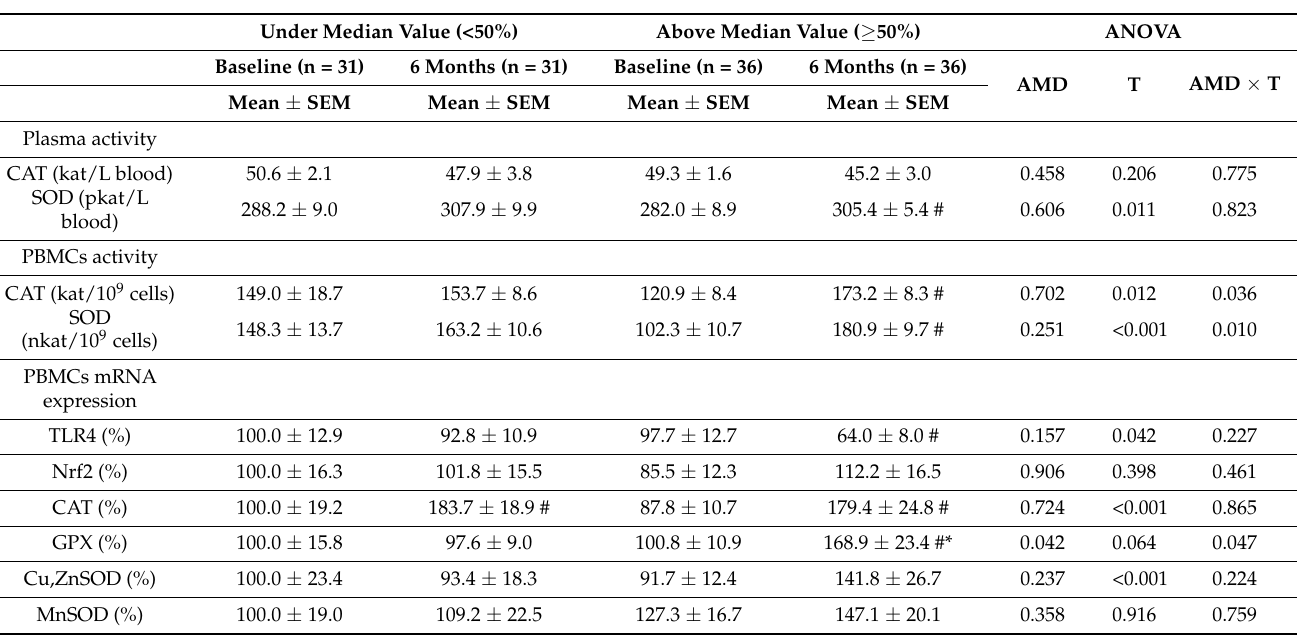
Table 5. Oxidative stress biomarkers in PBMCs and plasma of participants “Baseline” and “6-month intervention” stratified by adherence to Mediterranean diet